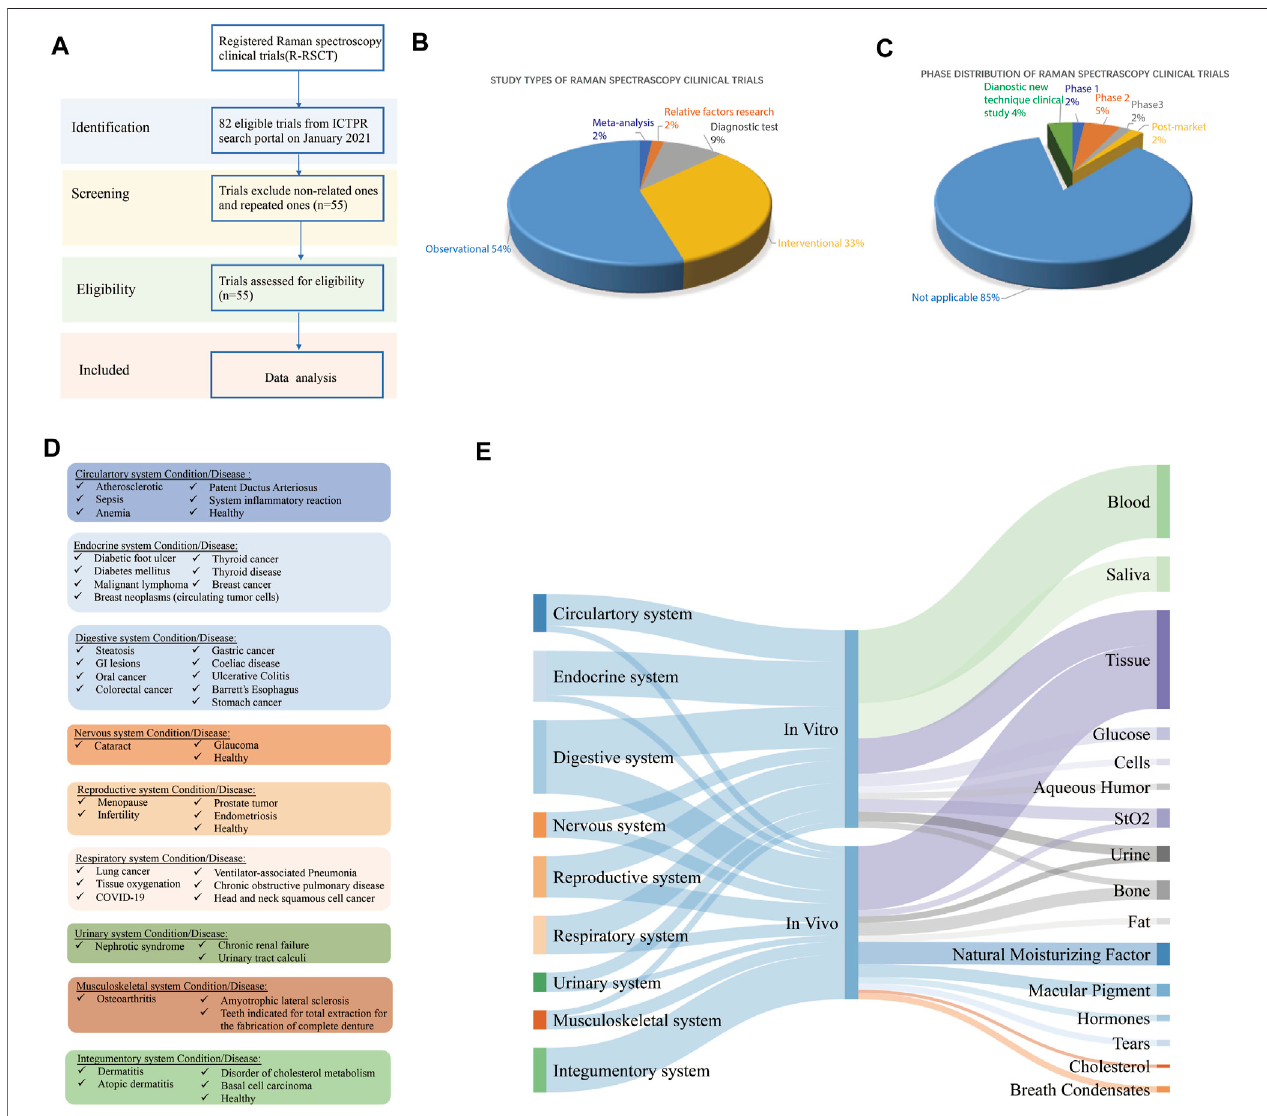
FIGURE 1 | (A) Flowchart of Raman spectroscopy clinical trial selection, (B) characterization of study types of registered Raman spectroscopy clinical trials (R-RSCTs), (C) phase distribution of R-RSCTs, (D) disease classi fi cation of R-RSCTs according to physiological systems, and (E) the Sankey diagram of physiological systems, in vivo/in vitro , and sample types in